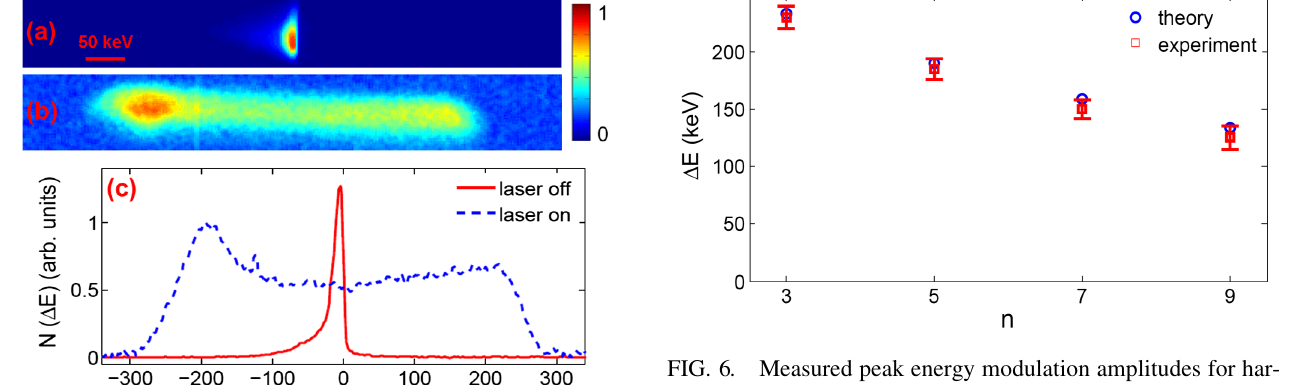
FIG. 6. Measured peak energy modulation amplitudes for har- monic interactions at various orders. The theoretical values are calculated assuming a perfect undulator with no phase error and a beam with exact on-resonance energy.FIG. 5. Measured beam energy distributions with laser off (a)